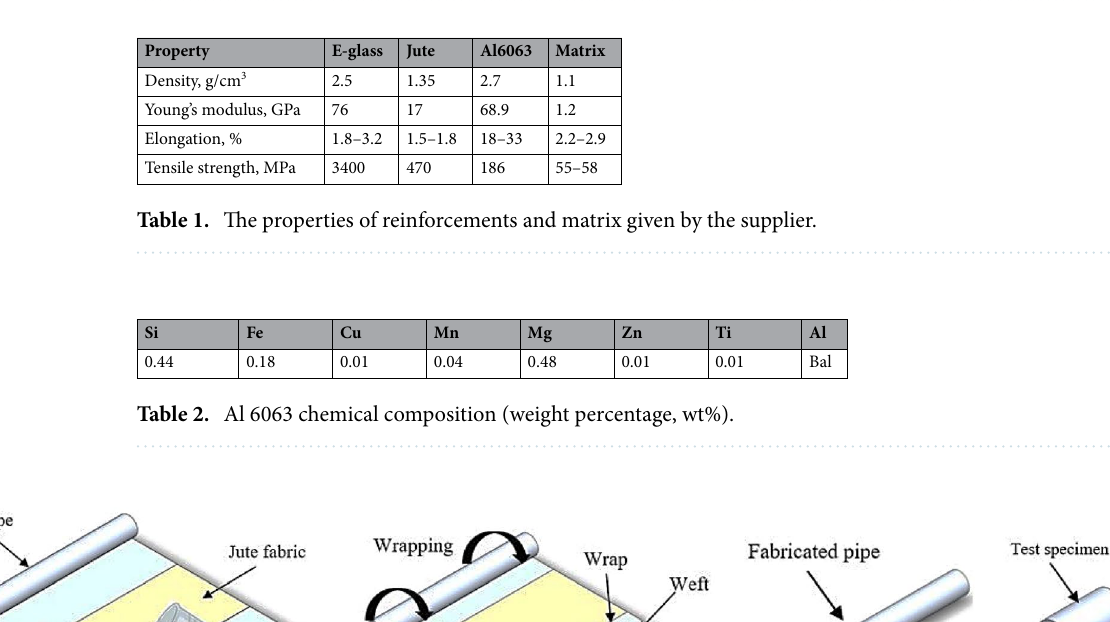
Figure 1. Surface images of ( a ) Al 6063 pipes, ( b ) E-glass fabric woven fabric, and ( b ) woven jute fabric.